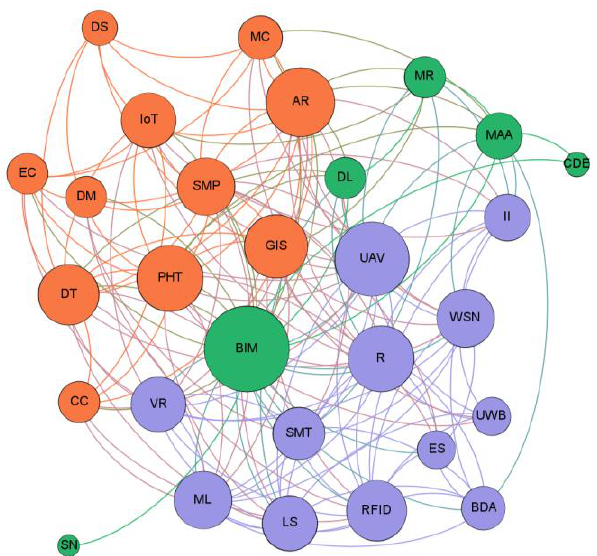
Figure 10. Full network analysis—modularity.